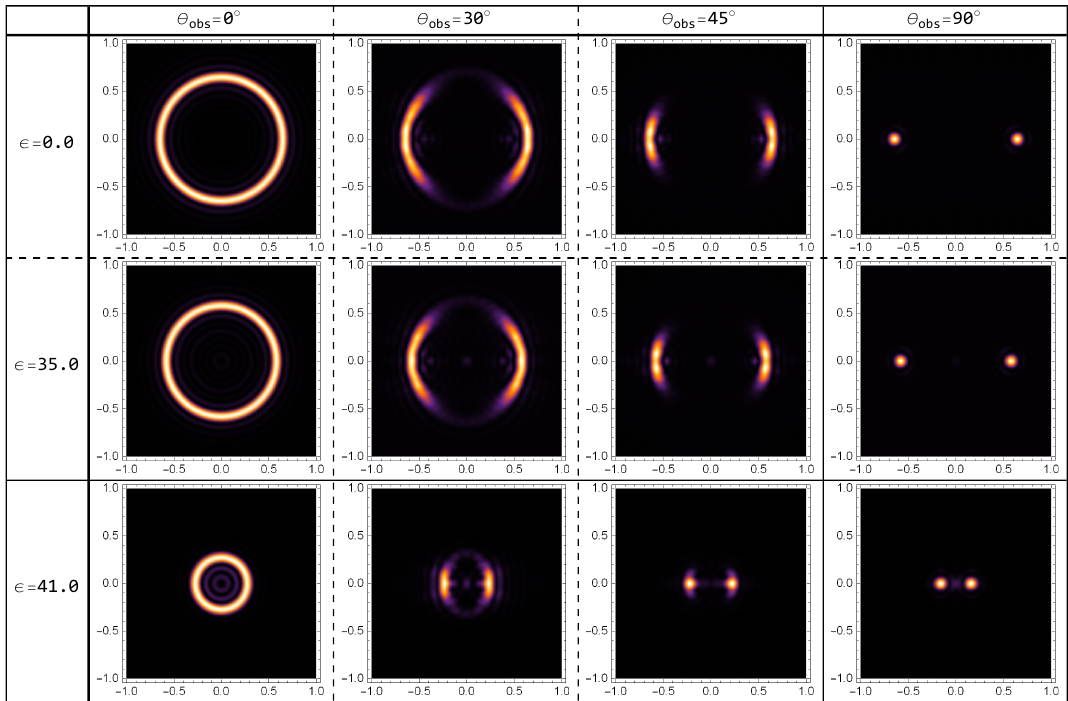
Figure 10 . The image for a vector-mode perturbation. We calculate the image of a dissipation part of the response, where r h = 0 . 3 , ω = 80 , d = 0 . 5 , and σ = 0 . 01